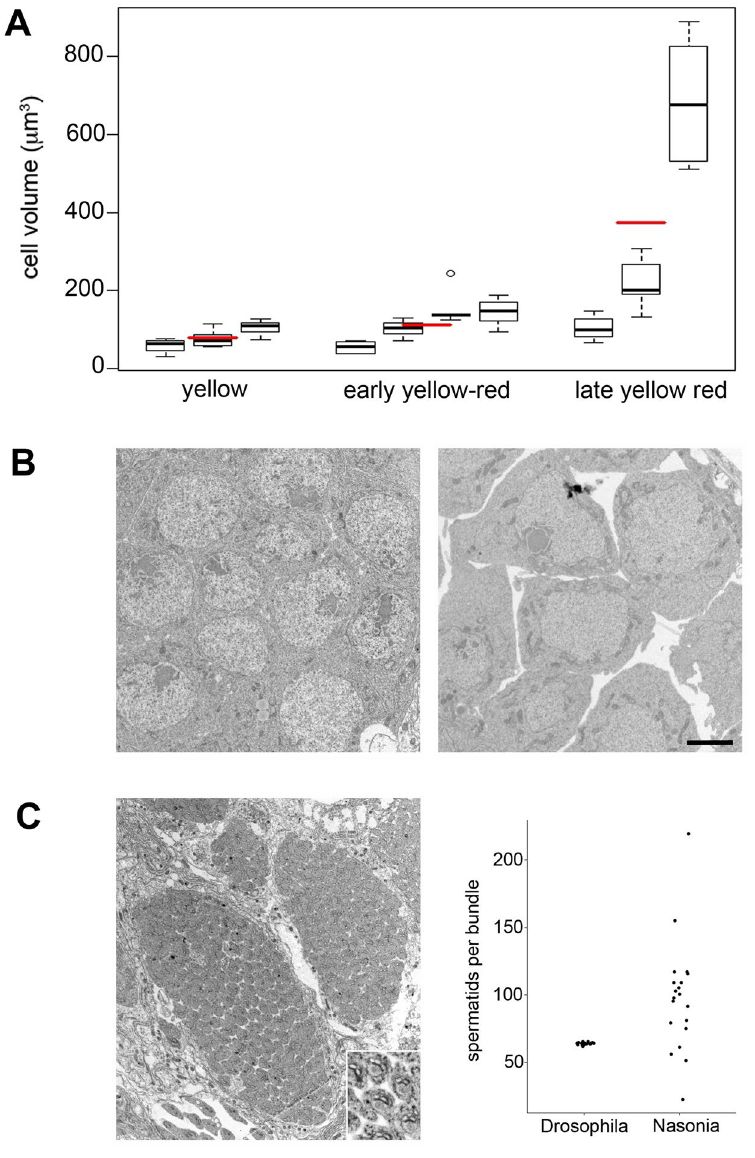
Figure 4. Wasp spermatogenesis produces bundles with highly variable spermatid numbers. ( A ) Cystocyte volume averages across three different pupal stages. Dark black lines represent means for a given cyst. Red lines represent means for all cyst means within each pupal stage. Boxes depict the interquartile range for each each cyst mean, and the whiskers are 1.5 times the interquartile range. ( B ) Left, a cyst of germ cells taken from a testis of an early yellow-red male pupa. Right, a cyst of germ cells taken from a testis of a late yellow-red male pupa. Scale bar is 2 μ m and applies to both panels. ( C ) Left, a cross section taken from the posterior end of a testis from a yellow-black male pupa depicting three spermatid bundles, each containing a different number of spermatids. Inset is a high magnification of the sperm tails showing cross sections of the mitochondrial derivatives and axonemes for a cluster of spermatids. Right, a graph showing the number of spermatids per bundle scored for D . melanogaster testes and N . vitripennis testes. Scale bar in ( B ) is 2 μ m (also applies to ( A